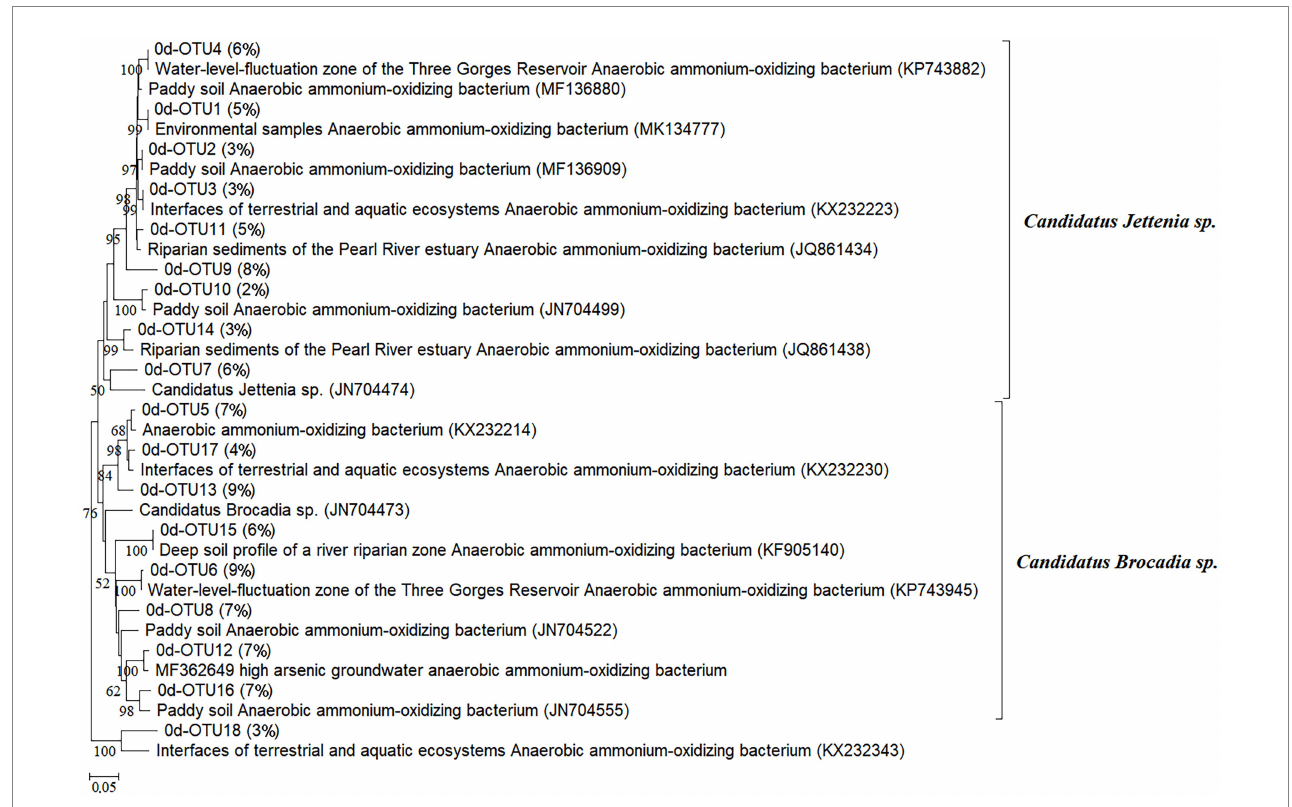
FIGURE 4 Phylogenetic analysis of the anammox bacterial hzs B genes at 0-day of culture in purple paddy